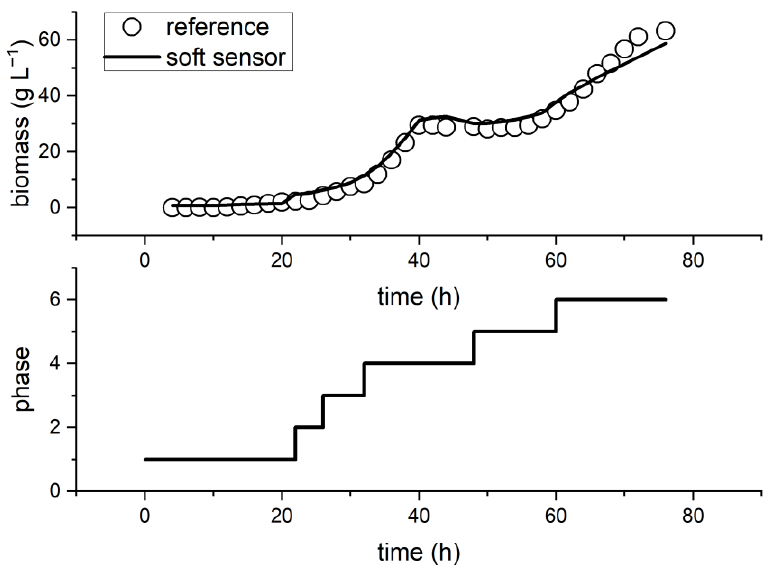
Figure 5. Prediction of the generalist soft sensor concept with reference values and detected phases for the biomass prediction of an example data set of the P. pastoris process.